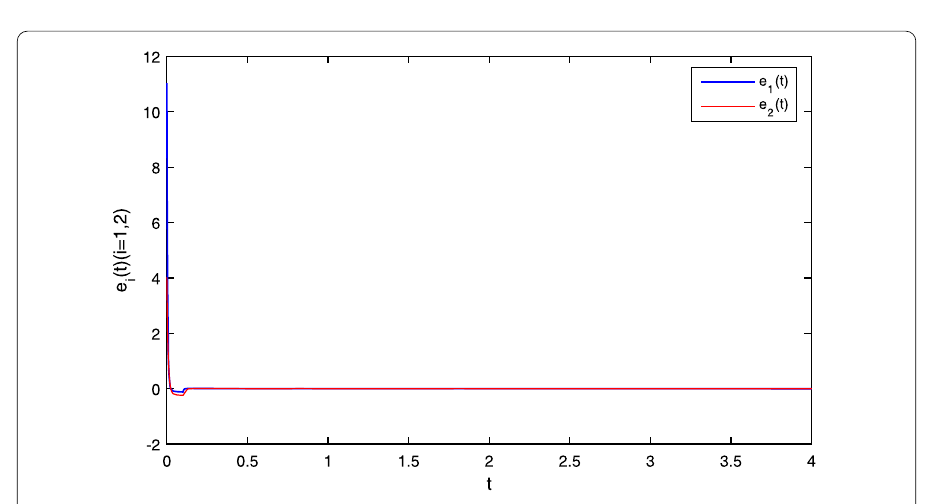
Figure 12 The synchronization errors e i ( t ) ( i = 1,2) state with β = –2